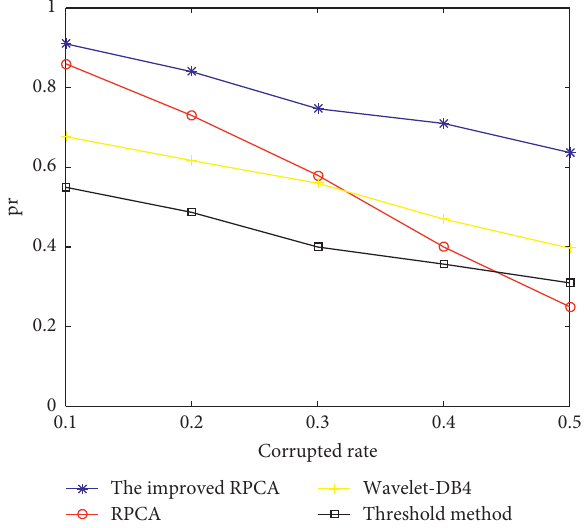
Figure 3: Performance comparison of anomaly